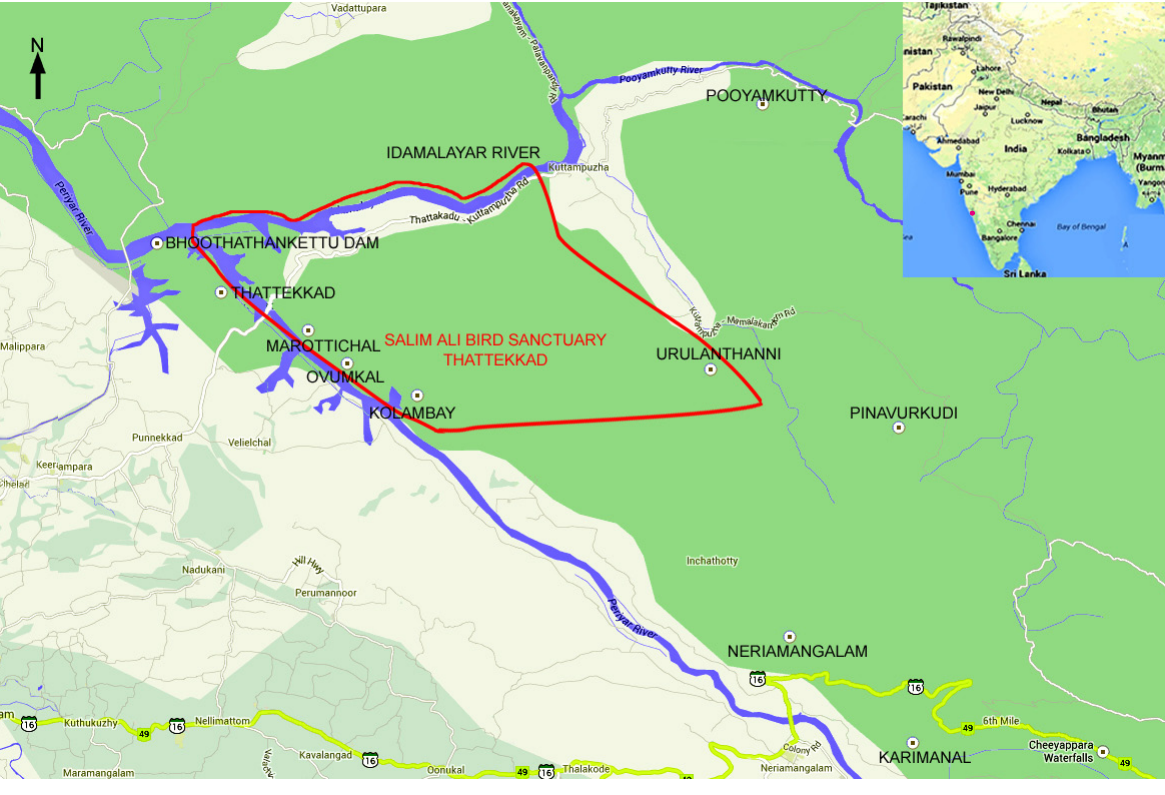
Figure 1. Localities selected for the